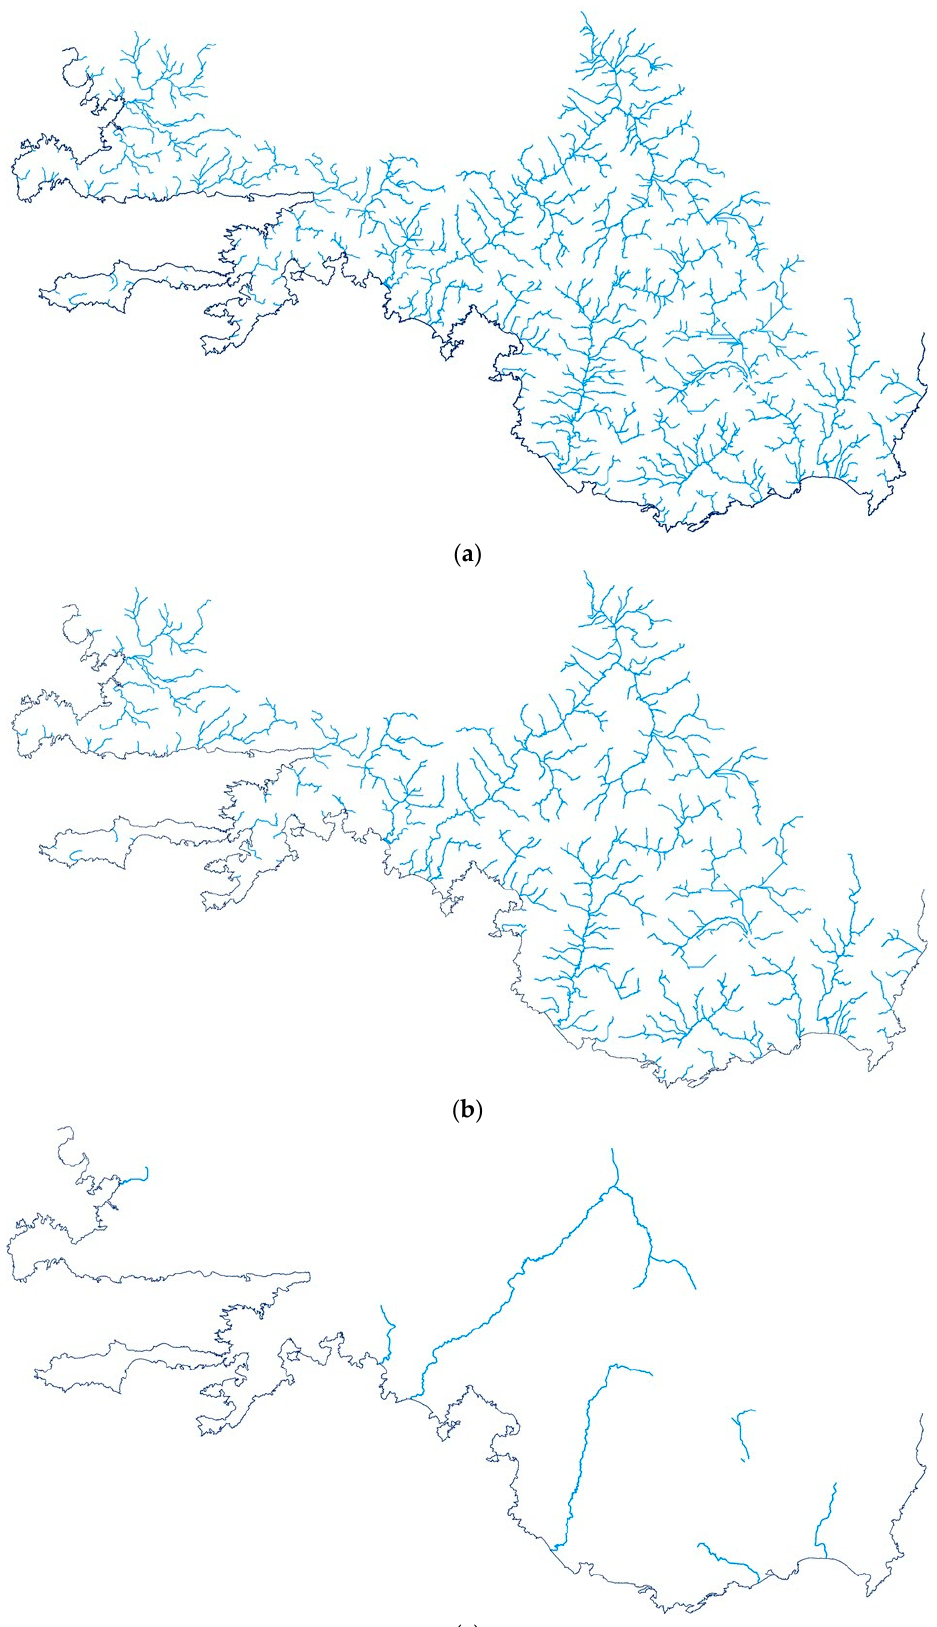
Figure 9. ( a ) The drainage network derived according to the Heine value. ( b ) The drainage network derived according to the BeST value. ( c ) The drainage network derived according to the LaST value.